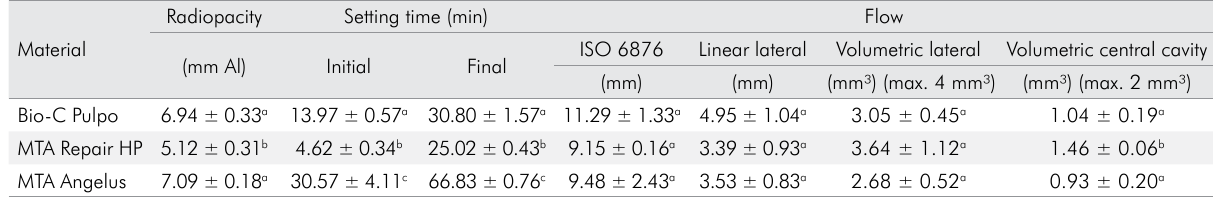
Table 2. Representation of mean and standard deviation values of radiopacity, setting time, and flow. Material